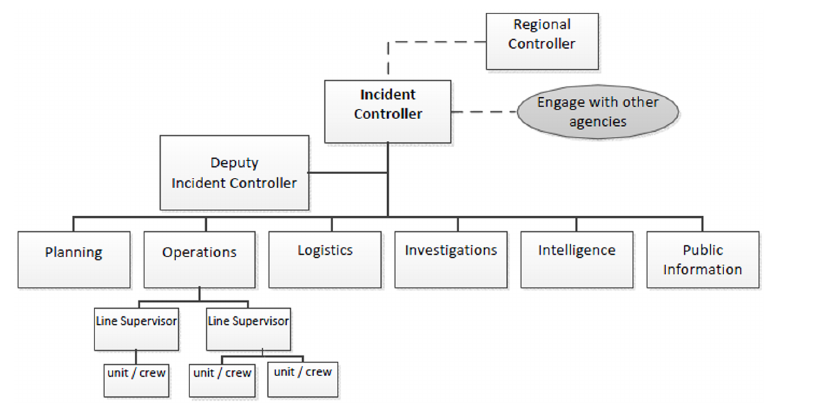
Fig 3. Typical incident management team